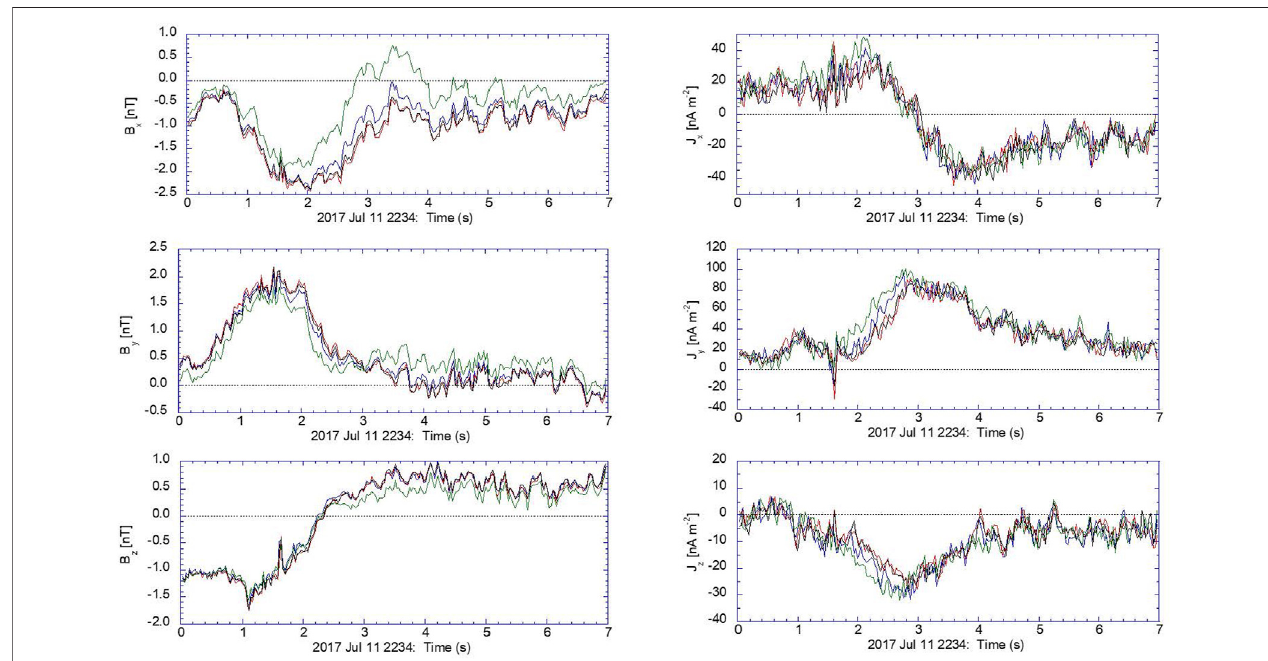
FIGURE 1 | Measurements from the four MMS spacecraft (MMS1, MMS2, MMS3, MMS4) on 11 July 2017 showing (left) the measured magnetic fi eld ^ B (cid:1) ( B , B , B ) from FGM (Russell et al., 2016) and (right) particle current density ^ J (cid:1) ( J x y z